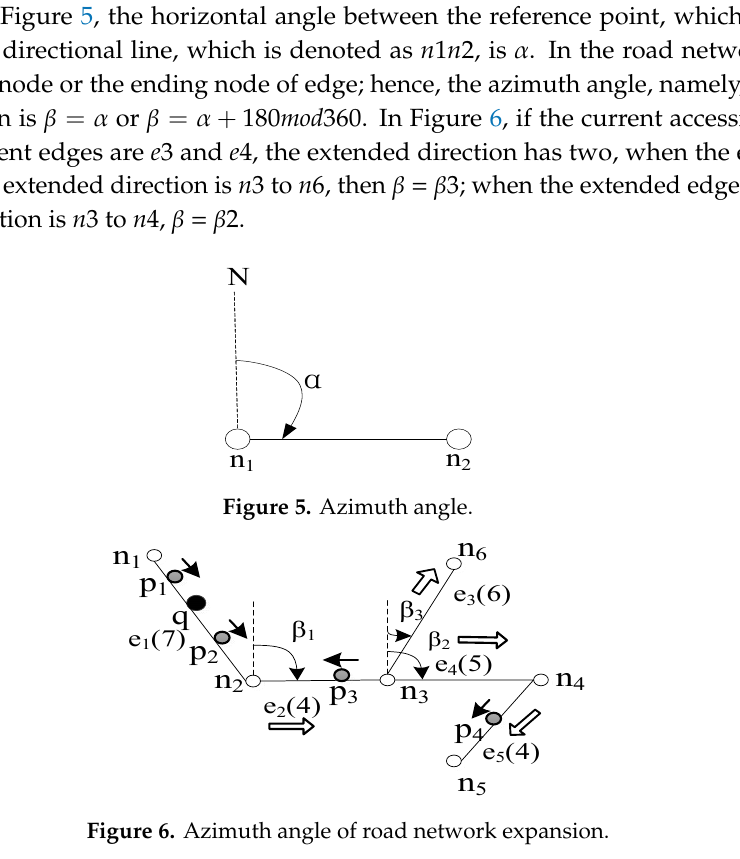
Figure 4. Direction-aware continuous moving K -nearest neighbor (DACKNN) algorithm process diagram.